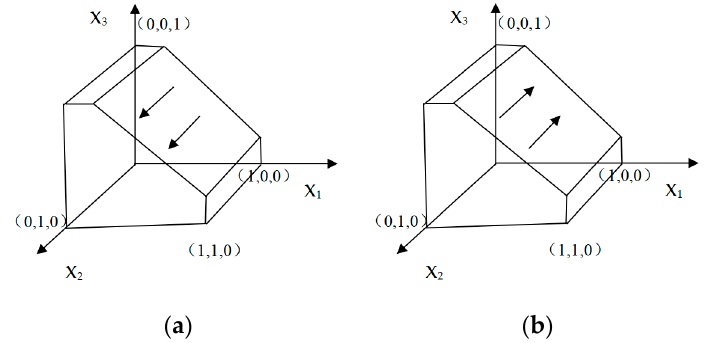
Figure 3. The evolutionary phase diagram of consumers.